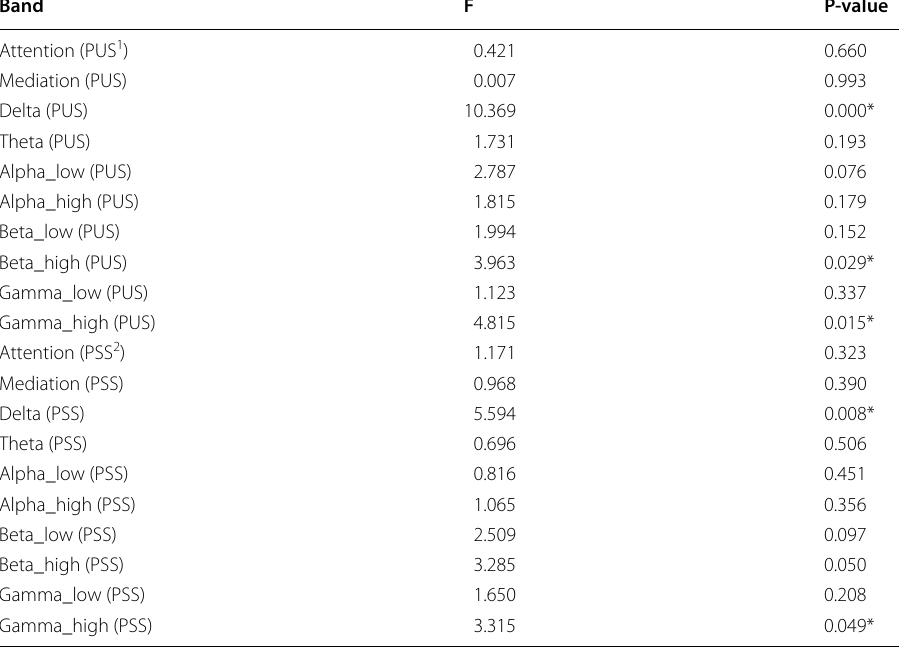
Table 5 Comparison of BS level between different types of groups at problem‑understanding and problem‑solving